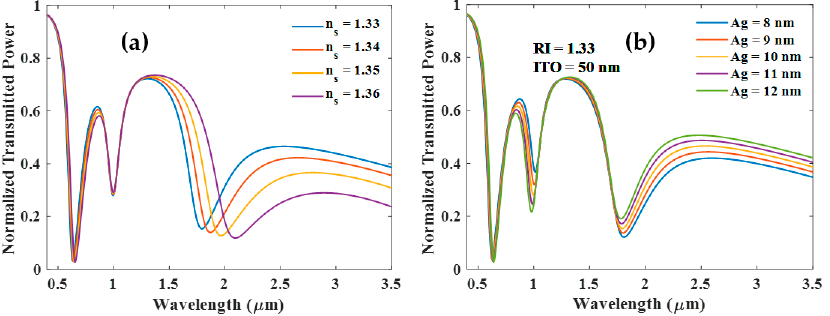
Figure 12. Normalized transmission spectra of sensing probe with ( a ) ITO (50 nm) + Ag (10 nm) + ITO(50nm)